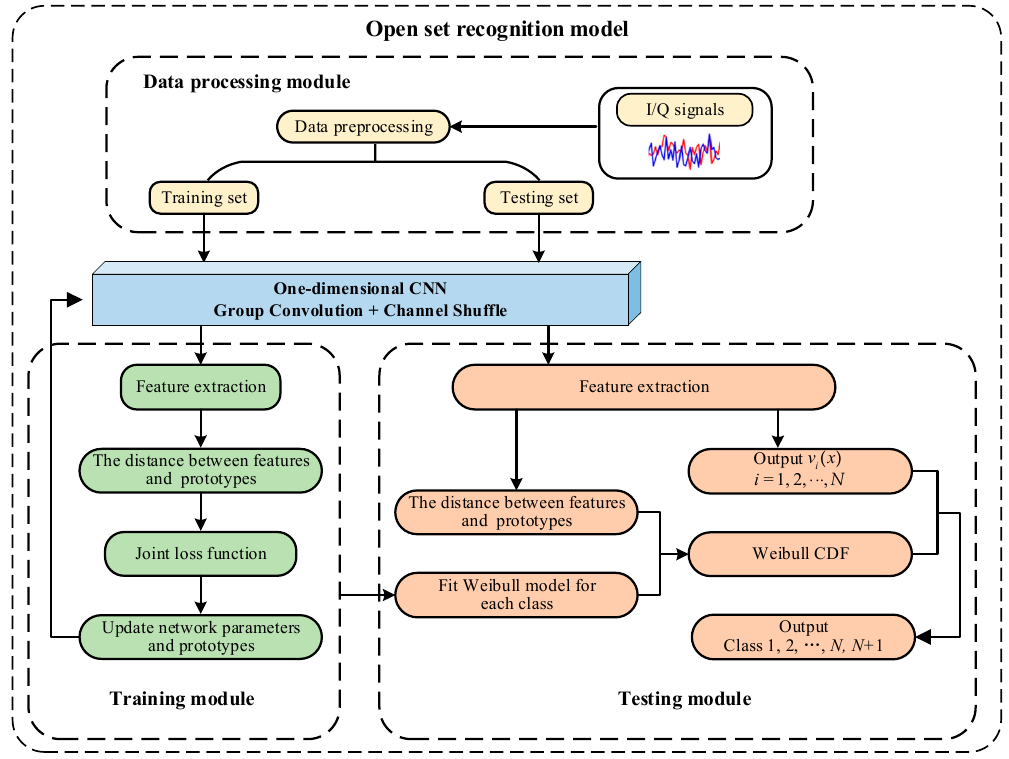
Figure 1. Open-set recognition model based on prototypical networks and EVT.